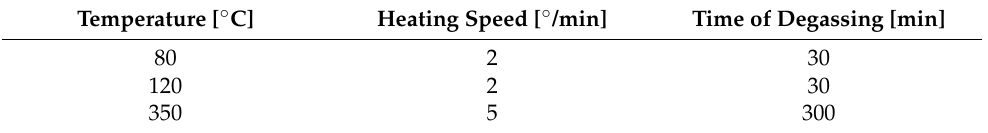
Table 4. Sample degassing process.